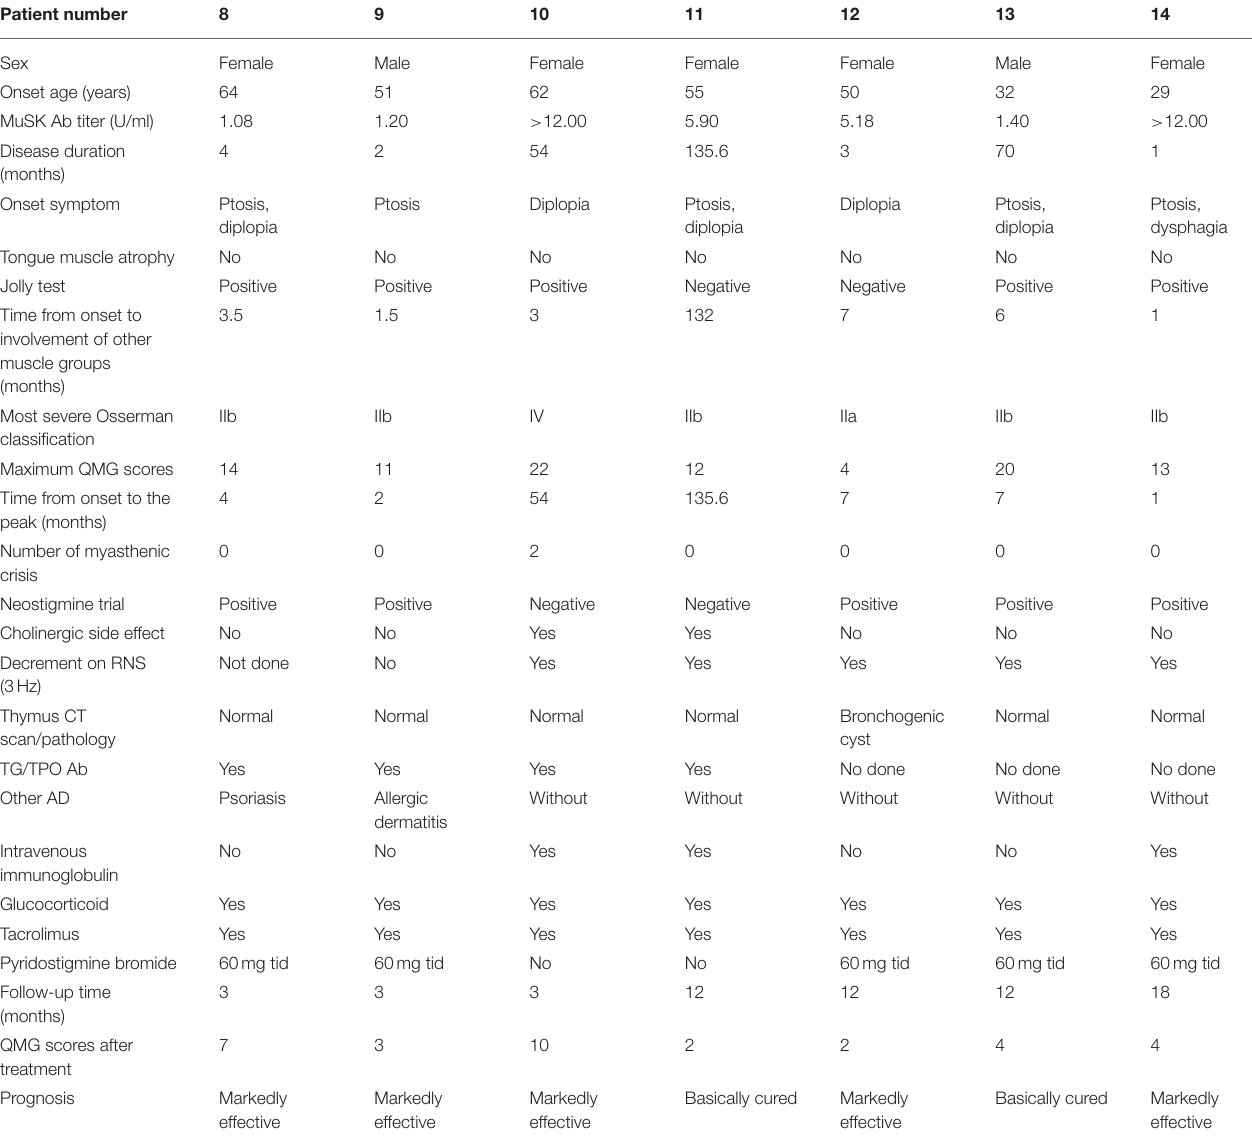
TABLE 1B | Detailed clinical data of the 14 MuSK-MG patients.